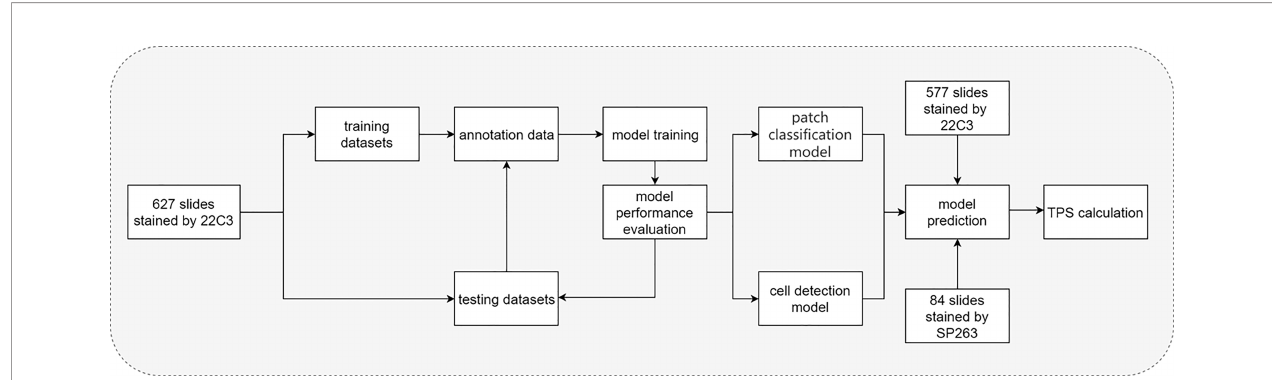
FIGURE 2 | Flow chart of the study. Flow chart of tumor proportion score assessed with arti fi cial intelligence-based diagnostic models in the pathological sections of lung cancer tissue samples stained with PD-L1